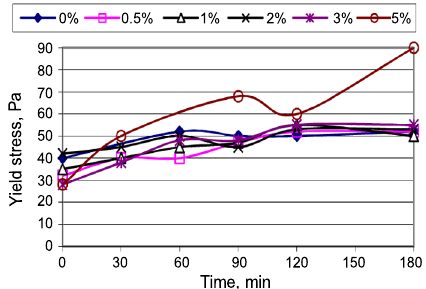
Fig. 14. Cement paste with CEM II N cement yield point